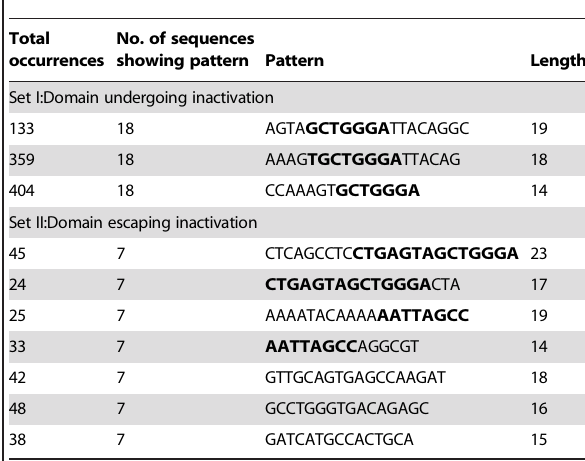
Table 3. List of domain specific patterns.